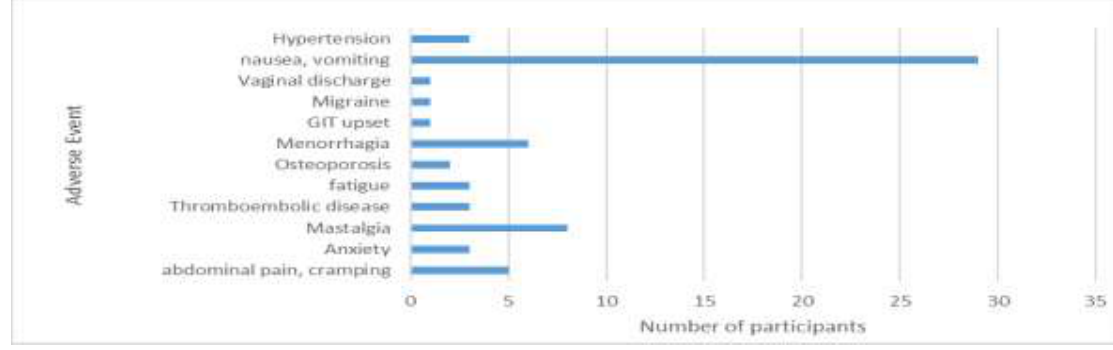
Figure 1. Community pharmacists’ responses on side effects.